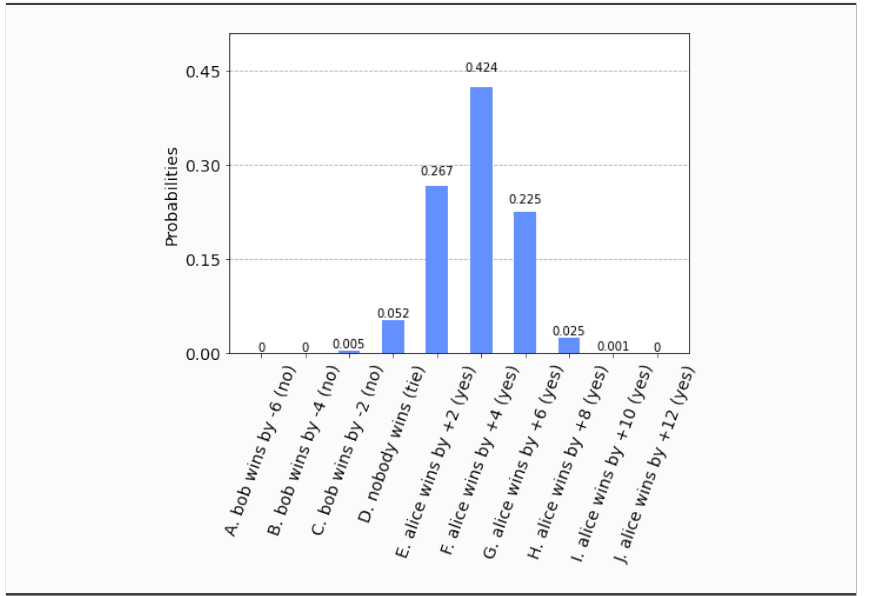
Figure 20. The possible outcomes and their probabilities with 2 independent legislators and r A = r B =